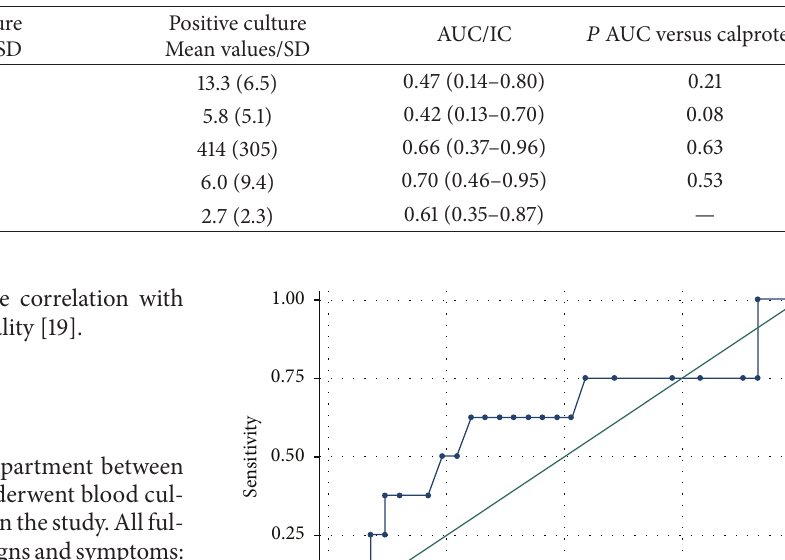
Table 1: Mean values, SD, AUC, and 95% CI of markers of infection.